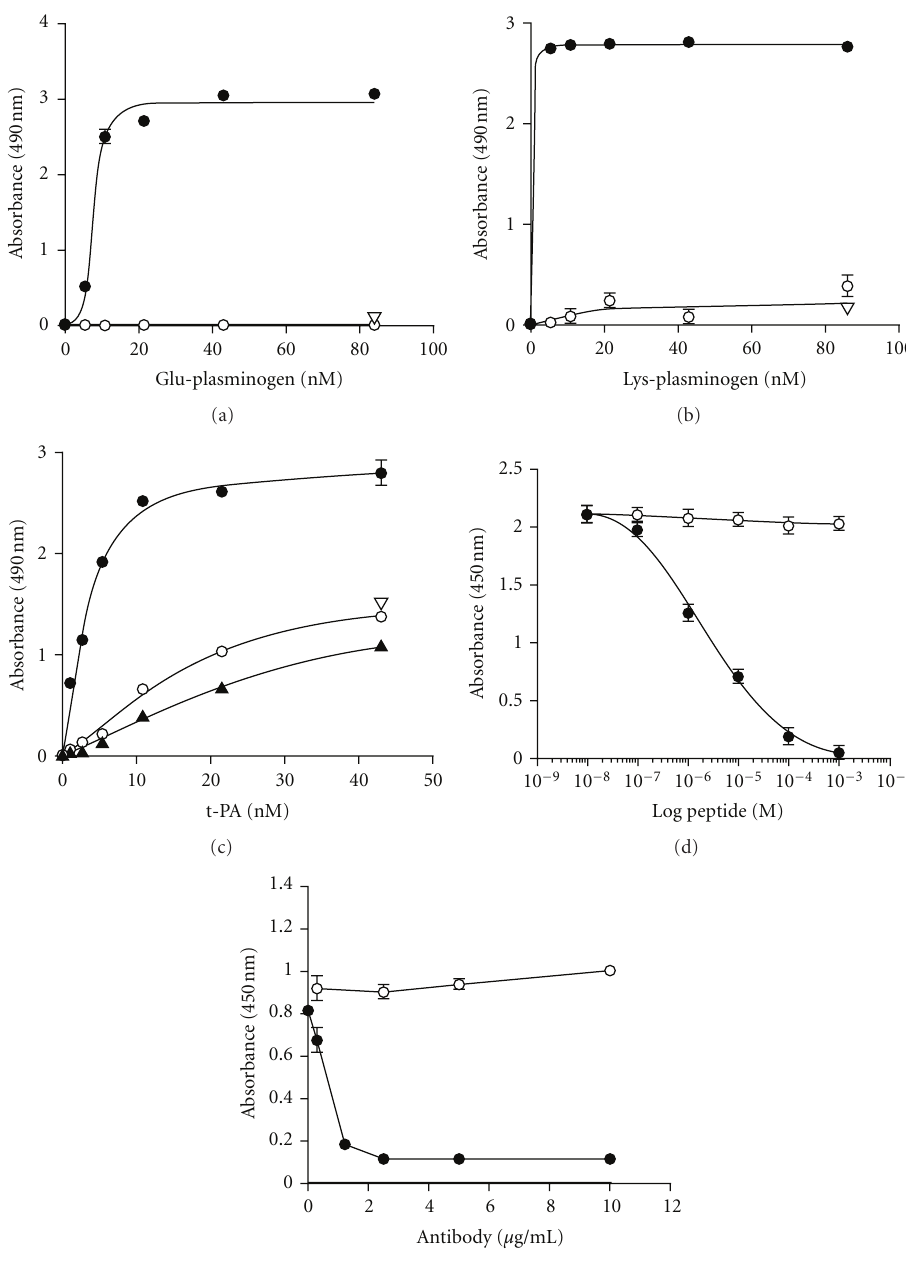
Figure 5: Plasminogen binds to the C-terminal peptide of Plg-R KT . The peptide, CEQSKLFSDK, corresponding to the amino terminus of Plg-R KT was coupled to BSA and coated onto wells of microtiter plates. Either Glu-plasminogen (a) or Lys-plasminogen (b) or t-PA (c) was then incubated with the wells, followed by antiplasminogen mAb [19] (a, b) or anti-t-PA polyclonal mAb (c) and detection with HRP- conjugated goat anti-mouse IgG (closed circles) as described in Materials and Methods. The binding was specific because it was blocked in the presence of 0.2M EACA (open triangles), consistent with the ability of EACA to inhibit plasminogen binding to di ff erentiated Hoxa9- ER4 cells. In additional controls, nonspecific binding to either BSA (closed triangles) or to the reverse peptide (open circles) was < 10% of binding to CEQSKLFSDK. (At high input concentrations of t-PA nonspecific binding increased but was < 10% of binding to CEQSKLFSDK at the concentration required for 50% saturation (3.2nM). In controls for the detection method, O.D. 490 values obtained using an isotype control antibody or in the absence of added plasminogen or t-PA were < 5% of the values for plasminogen or t-PA binding to immobilized CEQSKLFSDK. Panels d and e: biotinylated-Glu-plasminogen (25nM) was incubated with immobilized CEQSKLFSDK in the presence of increasing concentrations of (d) the C-terminal peptide, CEQSKLFSDK (closed circles), or a mutated C-terminal peptide with K147 substituted with alanine, CEQSKLFSDA (open circles) or (e) anti-Plg-R KT mAb35B10 (closed circles) or isotype control (open circles). Biotinylated Glu-plasminogen binding was detected with HRP-streptavidin and was 96% inhibited in the presence of 0.2 M EACA (not shown). Data are as mean ± SEM, n = 3, for each determination. This research was originally published in